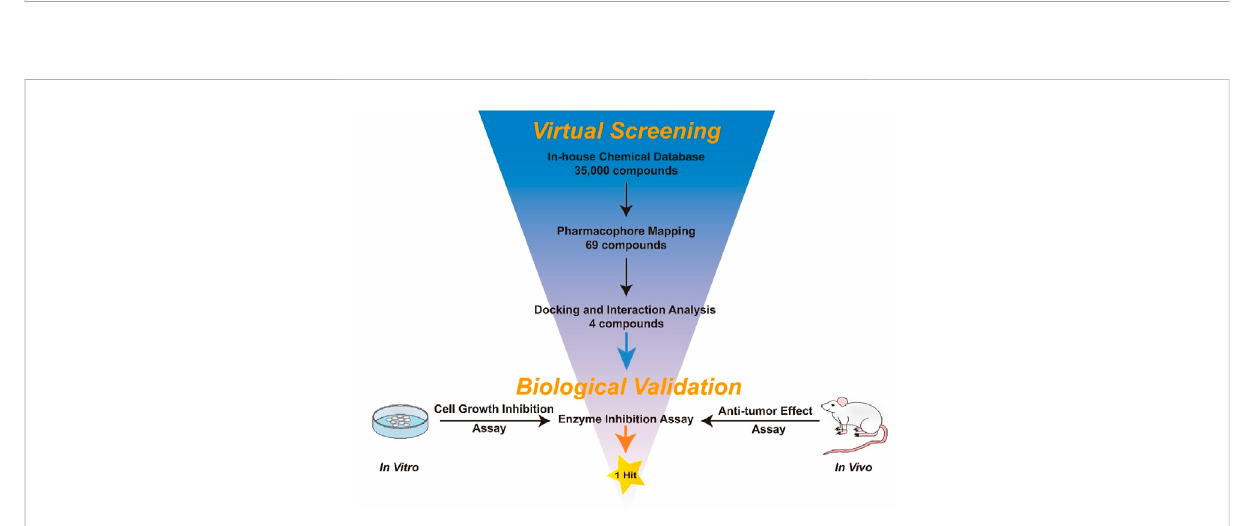
FIGURE 3 Schematic diagram of virtual screening and biological evaluation adopted in this study.